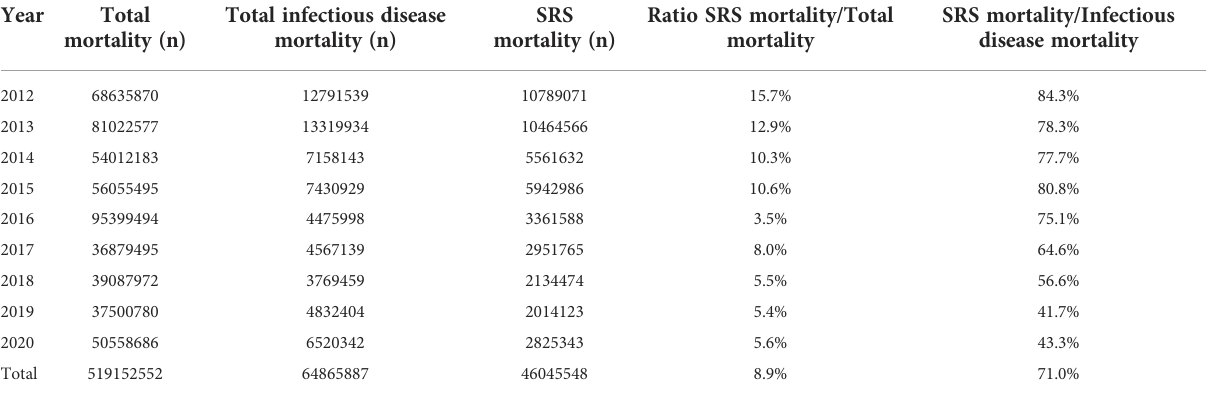
TABLE 1 Mortality (number of fi sh and %) of farmed salmon and trout in Chile between 2012 and 2020. Total mortality